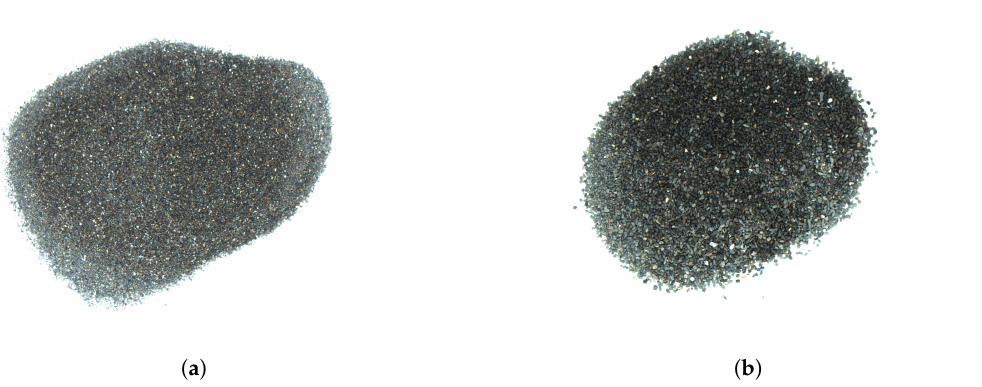
Figure 10. Drying copper ore at 3% moisture: ( a ) 0.2–0.5 mm particles; ( b ) 0.5–1 mm